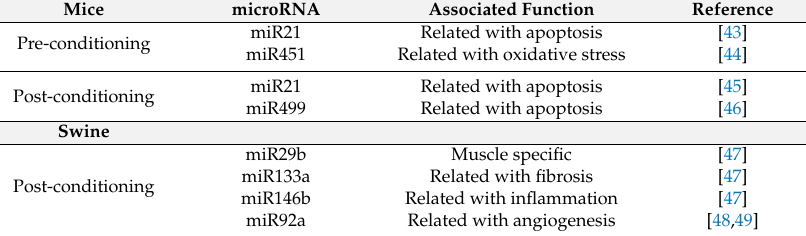
Table 2. miRNAs reported to contribute to ischemic